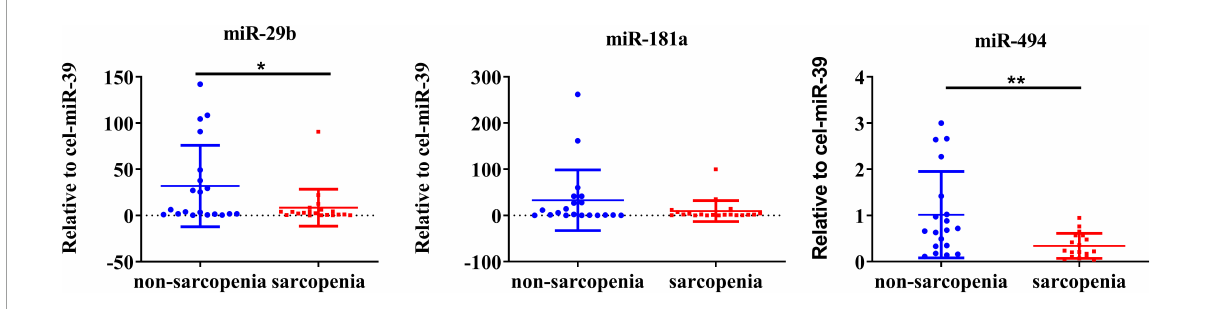
FIGURE2 Changes in circulating microRNAs in response to sarcopenia in the elderly. The expression level of miRNAs was normalized using spike-in cel-miR-39; unpaired T -test was used for these data; *compared to non-sarcopenia of the elderly; * P < 0.05, ** P < 0.01; n =